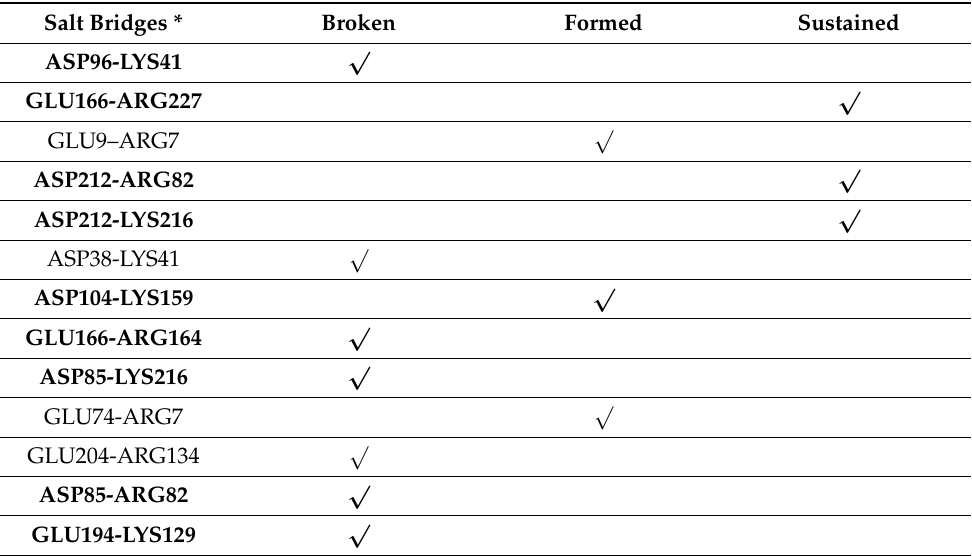
Table 2. Salt bridges within bR in the presence of graphene (experimental